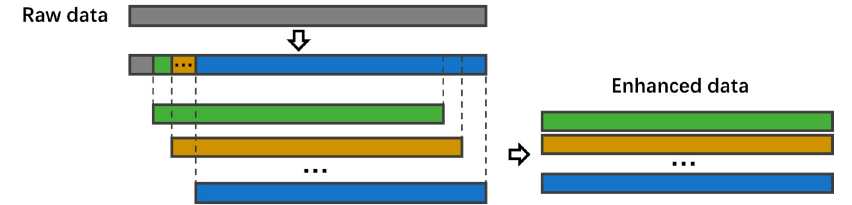
Figure 5. The training data were augmented by moving the sample window along the distance axis with a fixed step length.